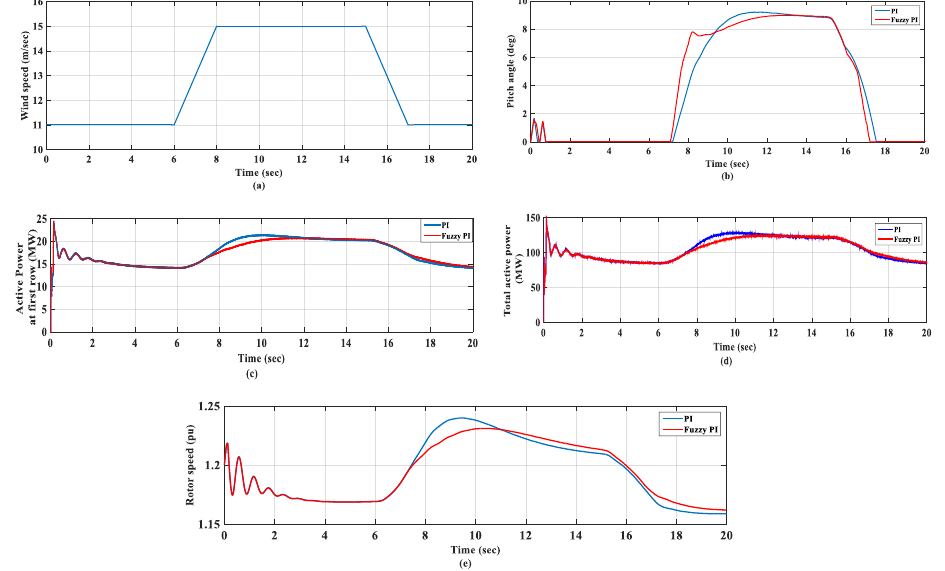
Figure 10. System response during ramp wind speed: ( a ) wind speed, ( b ) pitch angle, ( c ) active power of first row, ( d ) total active power, ( e ) rotor speed.